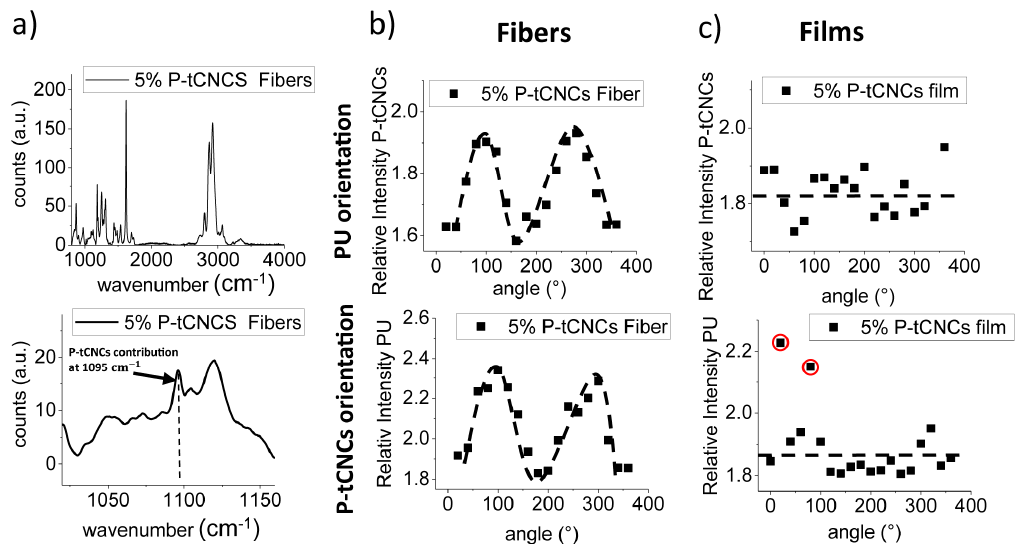
Figure 7. ( a ) Raman spectra of 5% P-tCNC containing nanocomposite fibers with the inset showing a zoom into the region of interest, highlighting the CNC contribution at 1095 cm − 1 . ( b ) 1D angular Raman plot for 5% P-tCNC nanocomposite fibers, showing the strong angular dependence of the 1095 cm − 1 Raman signal. ( c ) 1D angular Raman plot for 5% P-tCNC nanocomposite films, showing a lack of angular dependence of the Raman signal. Experimental outliers are circled in red.